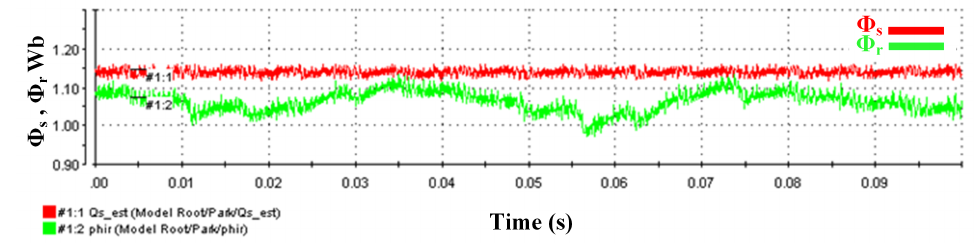
Figure 24. Experimental results of the stator and rotor flux responses of the improved strategy.